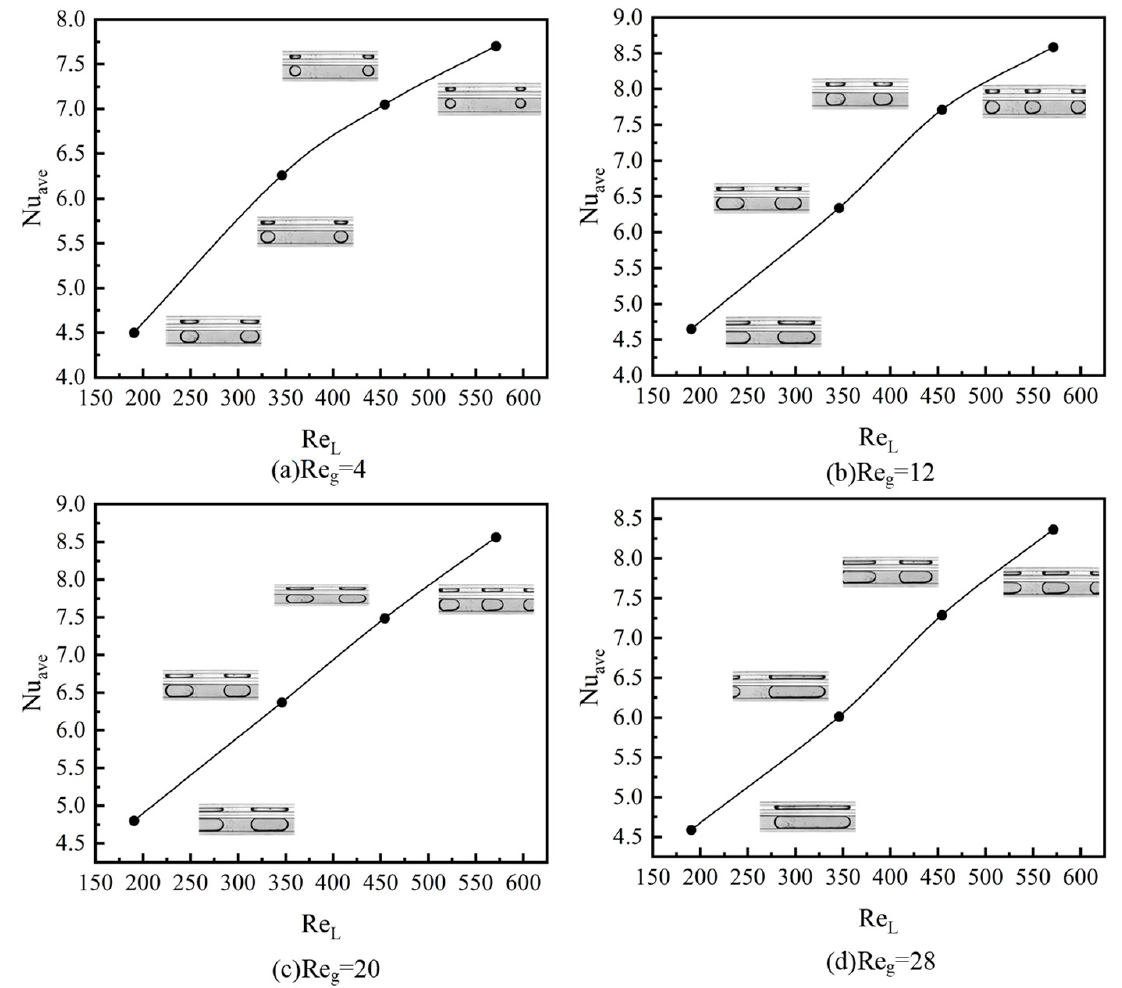
Figure 8. Effect of liquid phase Reynolds number on heat transfer in rectangular tube.